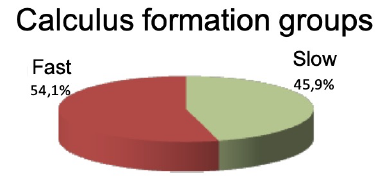
Figure 1. Pie chart showing sample distribution into two groups.